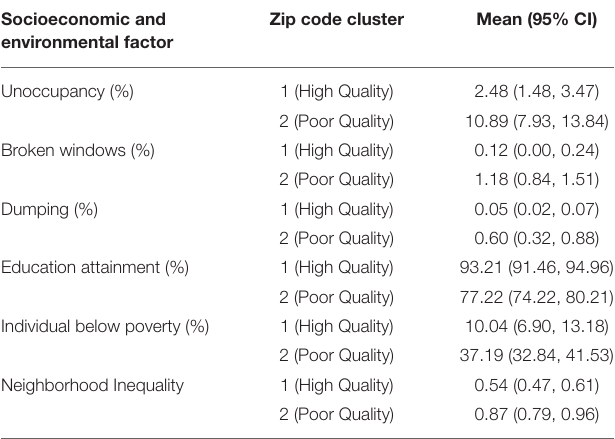
TABLE 1 | Clustering zip codes into poor and high-quality neighborhoods. Socioeconomic and environmental